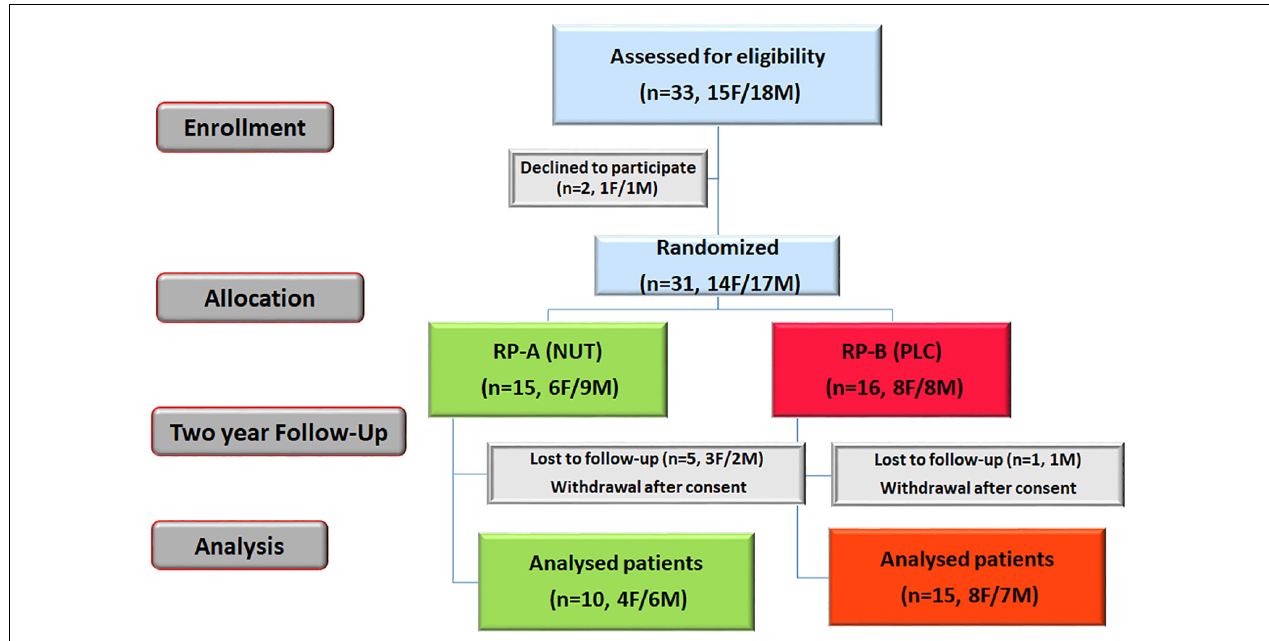
FIGURE 1 | NUTRARET flow chart of the participants. This was a randomized, double-blind, placebo-controlled study that investigated the effectiveness of a mixture of nutraceuticals (NUT) in ameliorating redox status and visual function in patients with RP. Thirty-one eligible RP patients were randomized to NUT group (A) or placebo (PLC) group (B), and daily received capsules with NUT or PLC for 2 years. F, female; M,